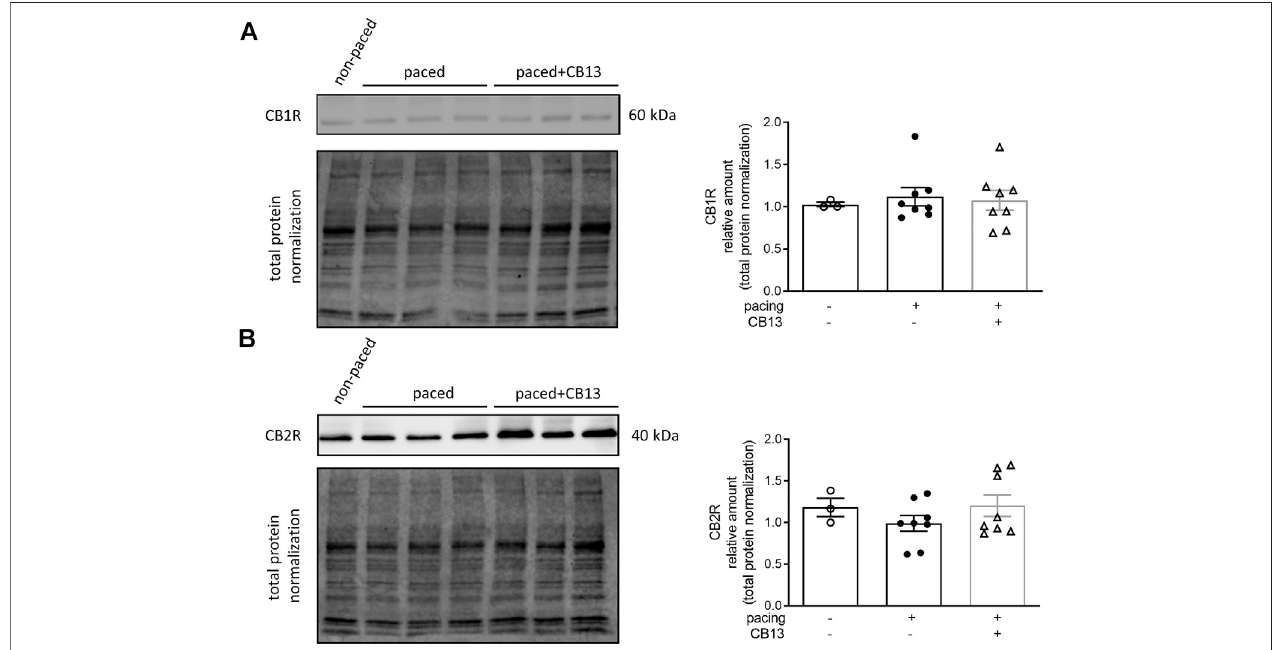
FIGURE 4 | Cannabinoid receptor protein levels remain unaltered in atrial tissue. (A) CB1R and (B) CB2R protein levels within atrial tissue exhibit no signi fi cant changes between groups. n (cid:1) 3 – 8. Data presented as mean ± SEM. Data was tested for normality using Shapiro-Wilk normality test. Statistical signi fi cance was determined for non-normal data by Kruskal-Wallis with Dunn ’ s post-hoc for multiple comparisons (A,B) .